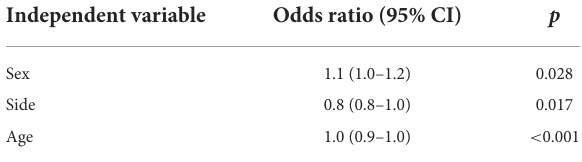
TABLE 2 Comparison of coronary angiography success rates RRA vs. LRA route—divided by age groups and for severe aortic stenosis